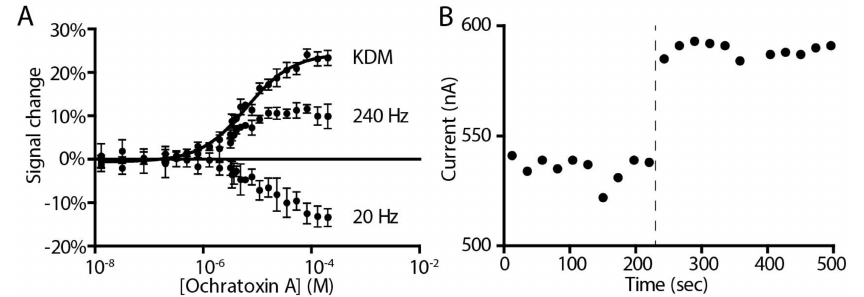
Figure 3. ( A ) The ochratoxin A-detecting sensor responds quantitatively to its target with a K D of 6.5 ± 0.6 µ M in, as shown here, a simple buffer sample. Kinetic differential measurement (KDM), which takes the difference between measurements obtained at signal-on and signal-off square wave frequencies allows us to improve the signal magnitude and self-correction for a more stable signal [21]. Error bars shown for the 20 Hz and 240 Hz data are the standard deviation of four replicate electrodes. Error bars shown for KDM are the standard error of the mean for four replicate calculations. ( B ) The E-AB ochratoxin A sensor responds rapidly when challenged with the target. Shown is the current of a single sensor interrogated multiple times in succession in buffer both before and after the sudden addition of saturating (800 µ M) target.